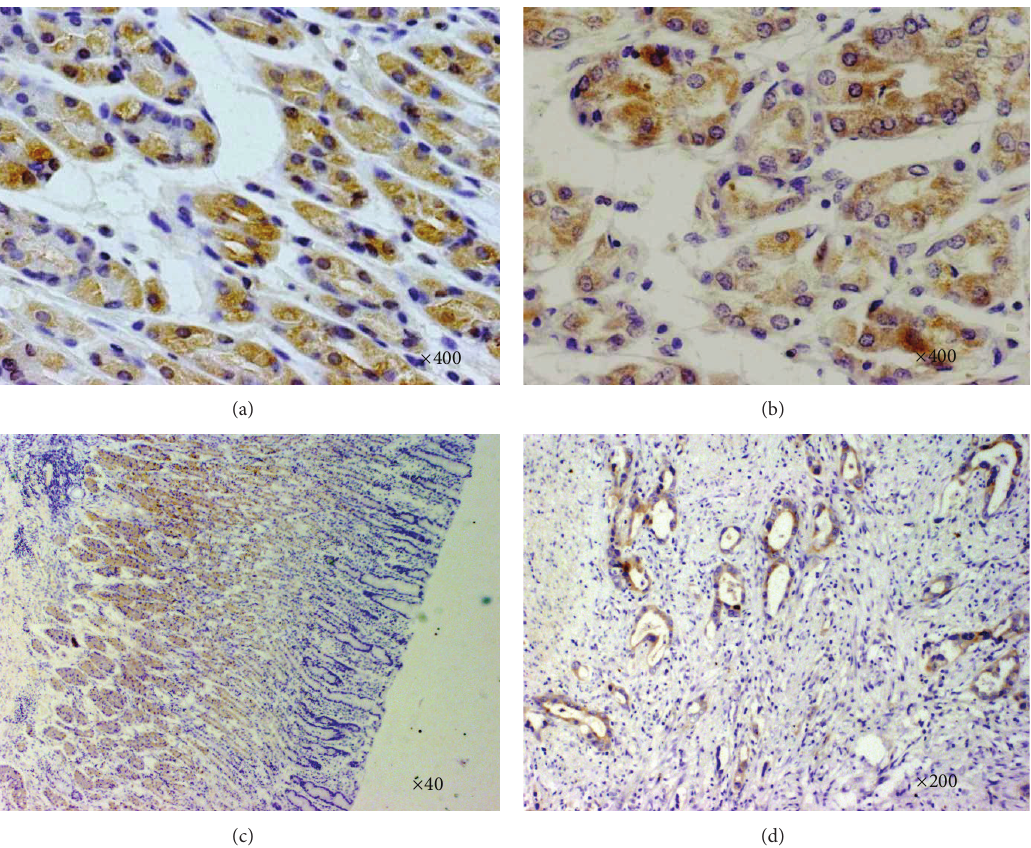
Figure 2: Immunohistochemical labeling for VEGF-C, VEGFR-3, CNTN-1, and D2-40 in primary lesion of gastric carcinoma. (a) VEGF-C expression is indicated as brown precipitates in the cytoplasm in gastric cancer. (b) CNTN-1 expression is observed as a dark brown colour in the cytoplasm. (c) VEGFR-3 expression is observed as a dark brown colour in the cytoplasm. (d) Tumour cells were identified inside D2-40-positive lymphatic vessels in some